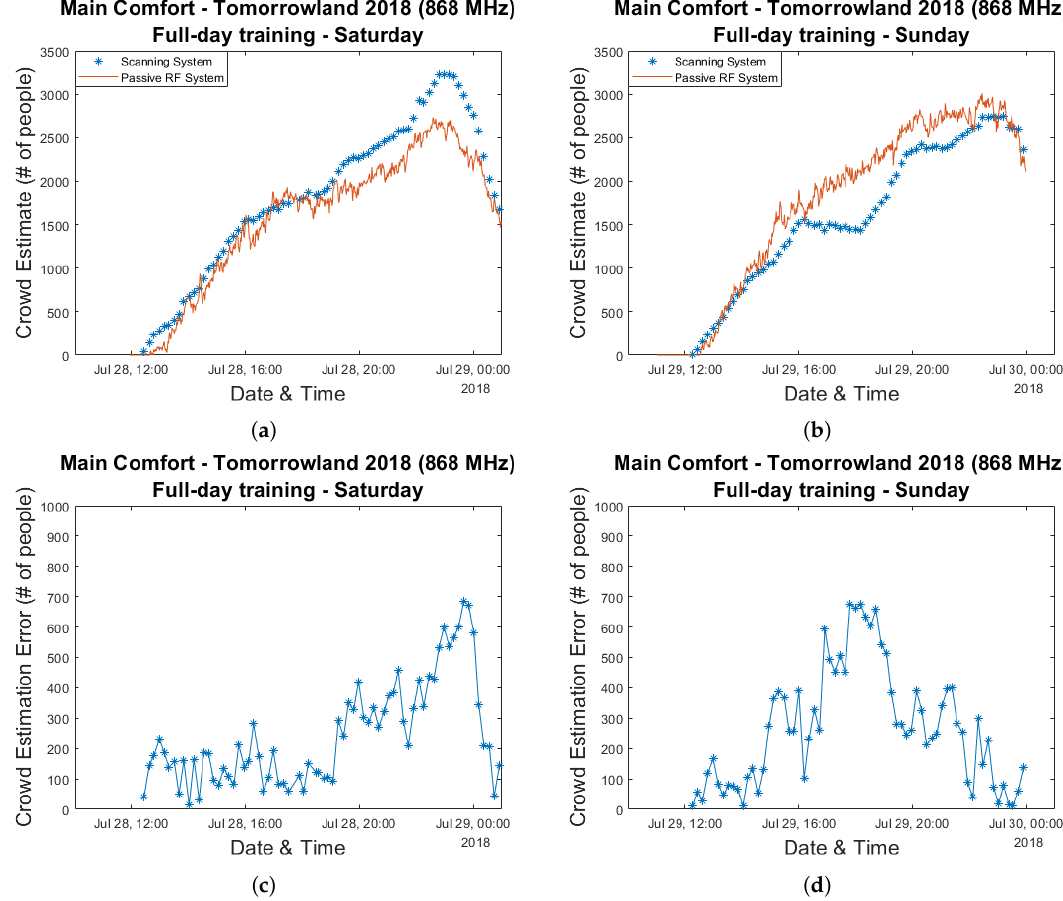
Figure 7. Crowd estimation graphs and their corresponding error graphs for a model trained using the data from an entire day and evaluated based on the data collected during the other day. Plots ( a , c ) were created based on training data collected on Sunday 29 July 2018 and evaluated based on data from Saturday 28 July 2018. Plots ( b , d ) were created based on training data collected on Saturday 28 July 2018 and evaluated based on data from Sunday 29 July 2018.